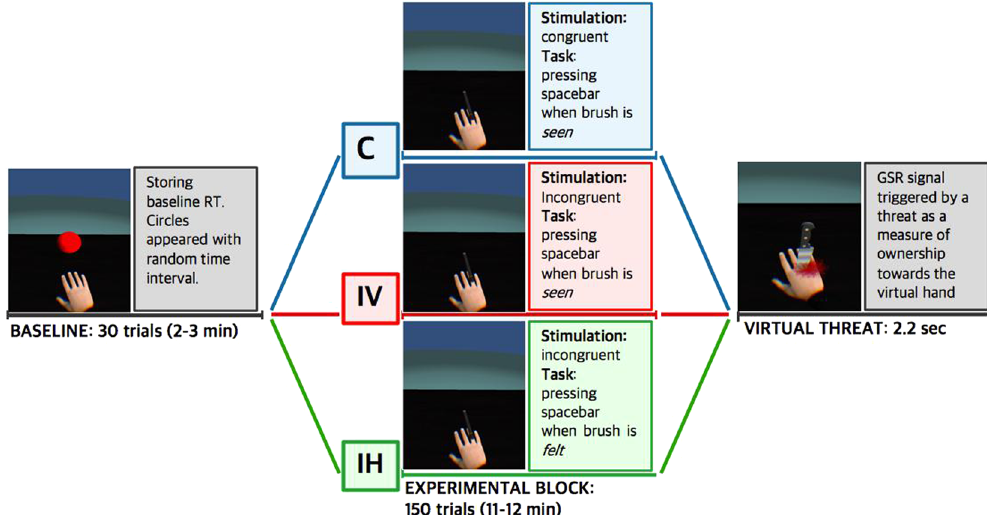
Figure 1. The experimental protocol. BASELINE: baseline block (“spheres”). EXPERIMENTAL BLOCK: the intervention block listing each of the three conditions: C: congruent condition (blue), IV: incongruent visual condition (red), IH: incongruent haptic condition (green). VIRTUAL THREAT: measure of physiological responses to a virtual threat. The same colours are used for every condition throughout the article (C: blue, IV: red and IH: green). Baseline block (A) and the virtual threat (C) were the same for every